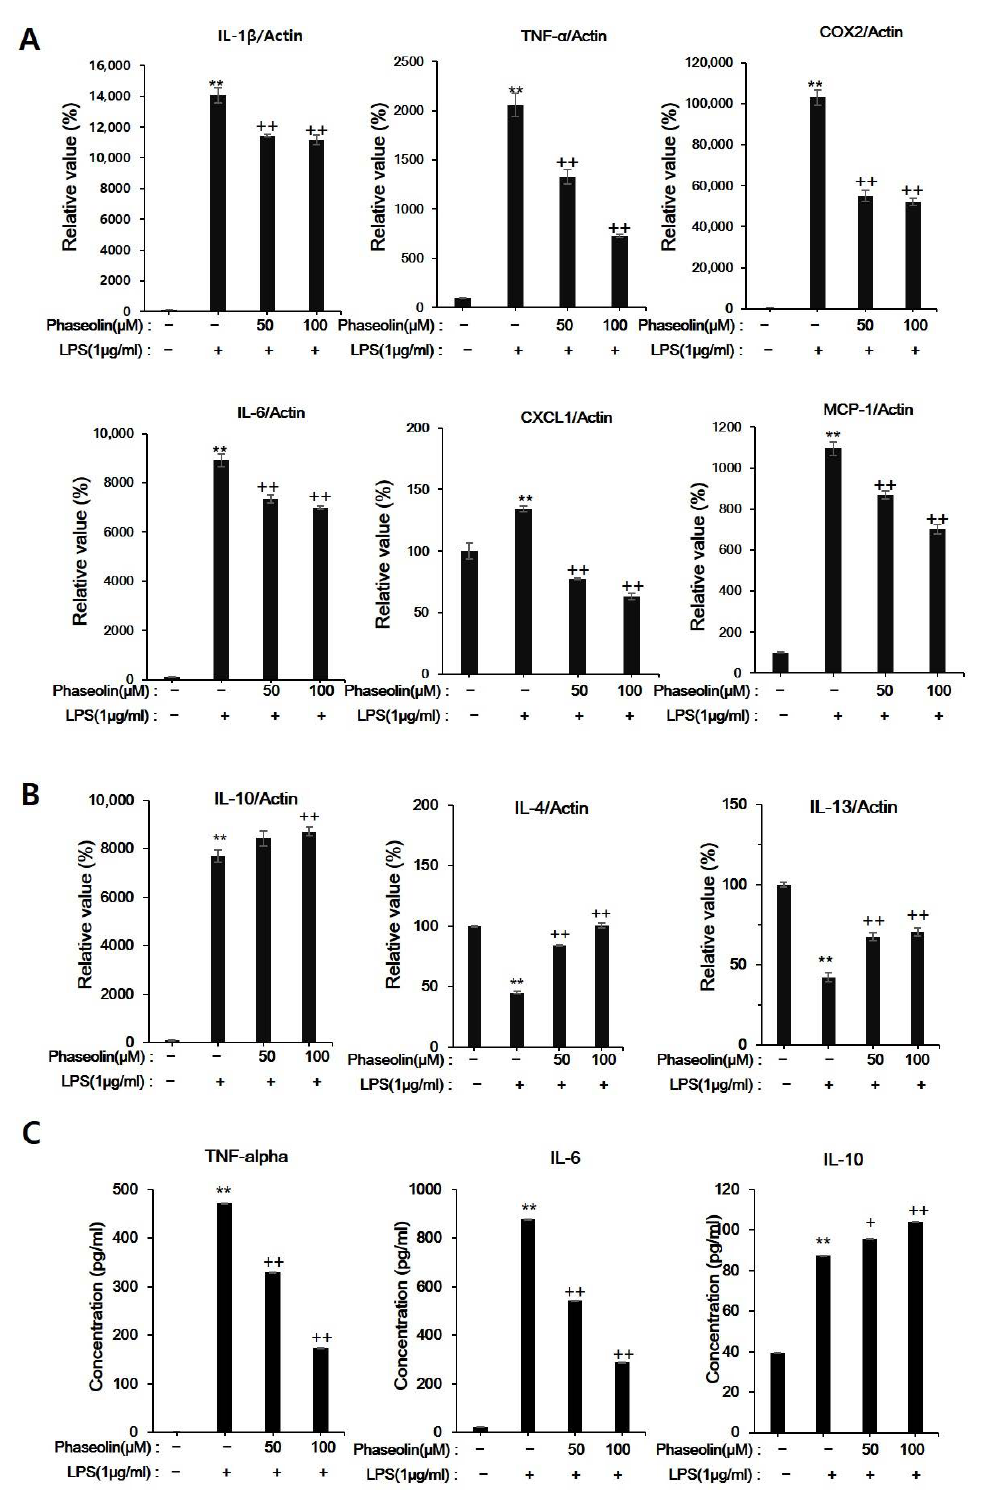
Figure 2. Effects of phaseolin on the mRNA expression levels of pro-inflammatory cytokines and other inflammation-related genes. Expression of ( A ) pro-inflammatory genes (such as interleukin (IL)-1 β and tumor necrosis factor- α ) and ( B ) anti- inflammatory mediators (such as IL-4, IL-10, and IL-13) at the mRNA level upon phaseolin treatment and LPS stimulation. The mRNA expression in the treated groups was normalized to that of in the negative control group (considered as 1) and is indicated as a relative value. ** p < 0.01, vehicle vs. LPS-treated group; + p < 0.05 and ++ p < 0.01, LPS vs. LPS + phaseolin- treated group. ( C ) Protein expression levels of pro-inflammatory genes (IL-6 and TNF- α ) and an anti-inflammatory mediator (IL-10) upon phaseolin treatment and LPS stimulation. IL: